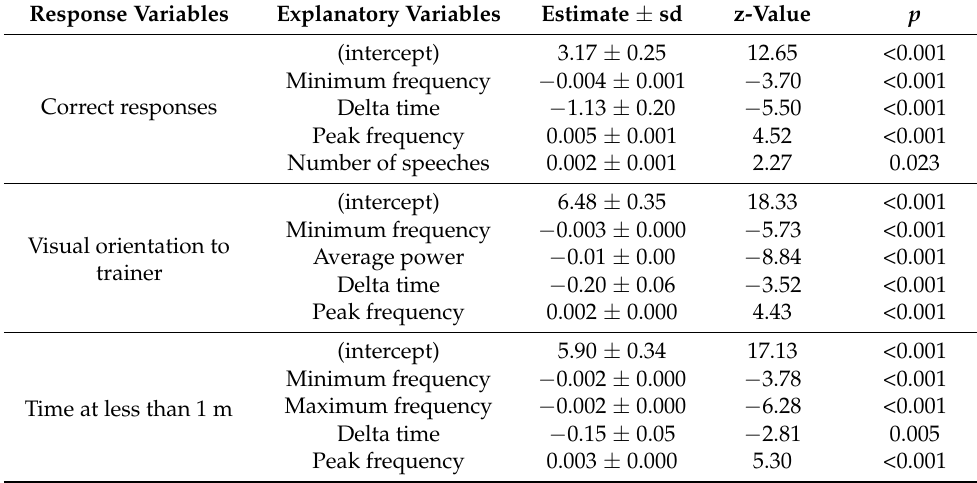
Table 9. Final Generalized Linear Mixed Models * run for wolves ( Canis lupus ), analyzing the effects of the variables minimum frequency; maximum frequency; delta time; average power; peak frequency and number of speeches on the response variables correct responses; visual orientation to trainer; time at less than 1 m; jumping; and tail